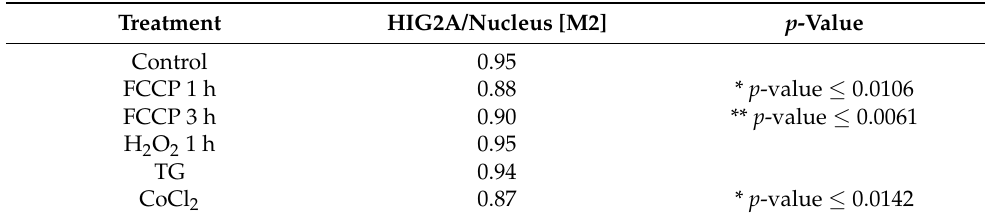
Table 3. The effect of mitochondrial stress on the subcellular localization of HIG2A in the nucleus of HEK293 cells: live-cell image